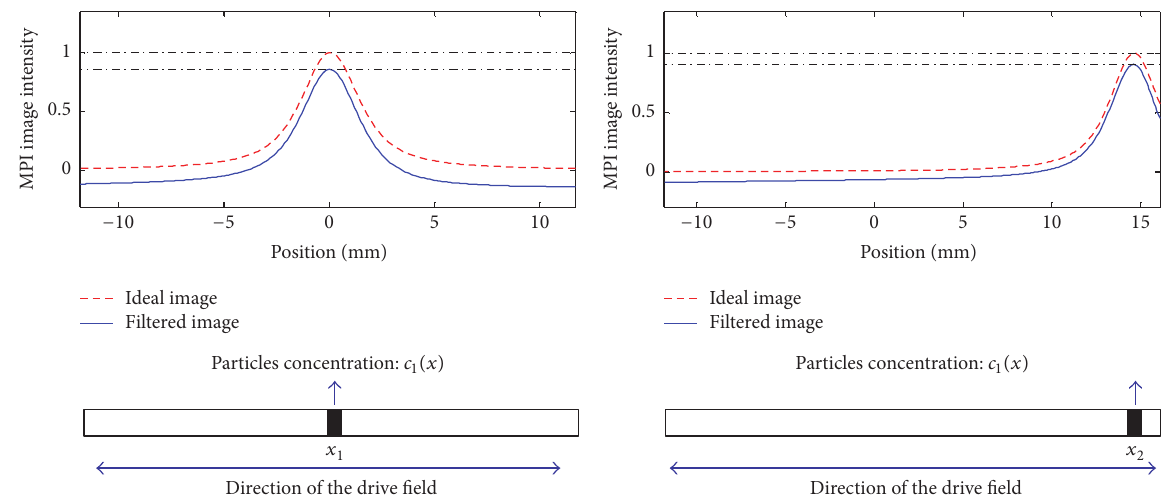
Figure 1: Effect of the filtering on an 𝑥 -space image of particles located at different positions in the FOV.